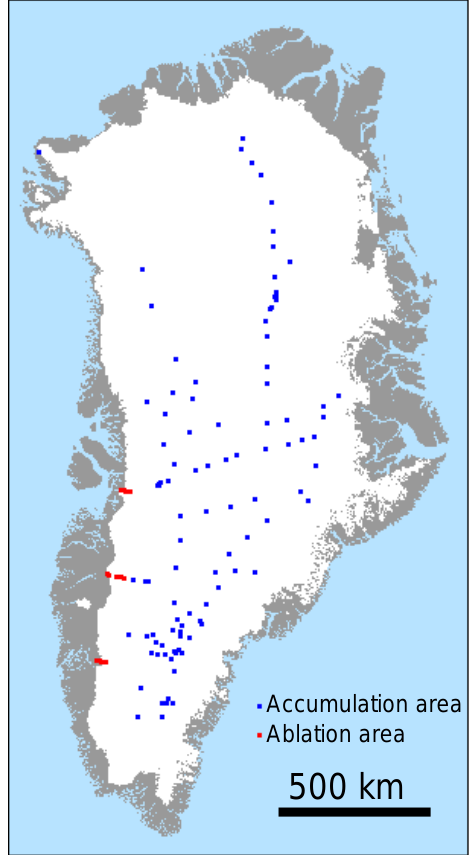
Fig. 2. Spatial distribution of in situ SMB observations.